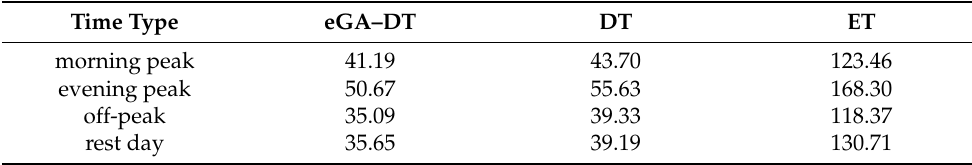
Table 6. MAE of eGA–DT, DT, and ET for different types of